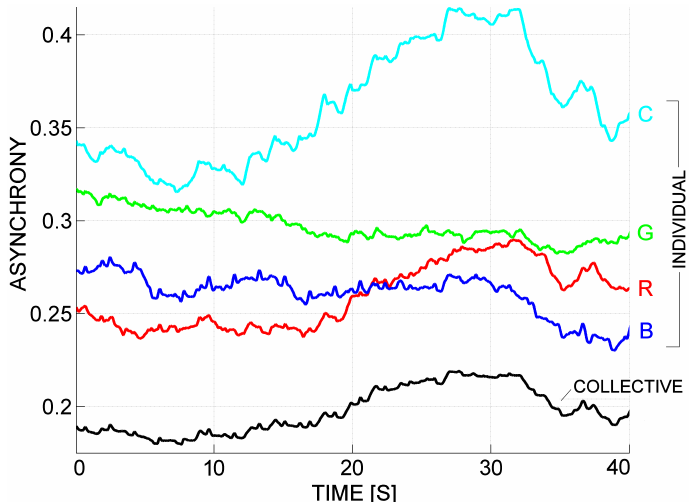
Figure 11. A scenario 40 s long, with individual (in color) and collective (in black) asynchrony, as a result of a macro-granulation with ∆ =